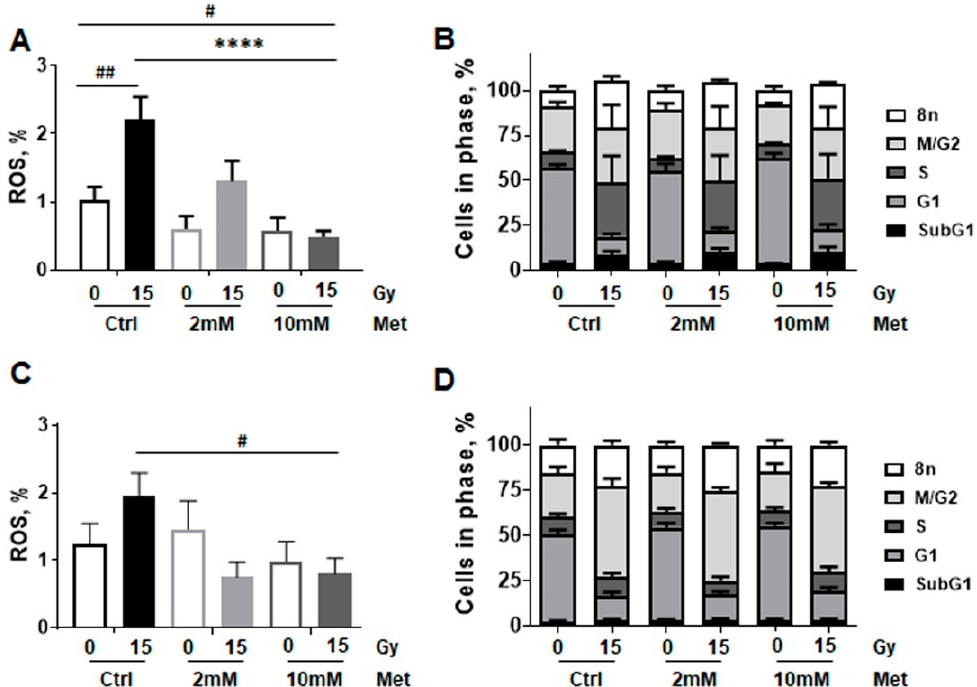
Figure 6. RT-induced cellular stress is reduced upon combined metformin treatment in epithelial cells established from normal lung epithelium. BEAS-2B ( A,B ) and HSAEC1-KT ( C , D ) lung epithelial cells were analyzed concerning reactive oxygen species (ROS) production ( A , C ) at 24 h of post RT and metformin (Met) treatment using dihydroethidium staining in combination with flow cytometry analyses. Data are shown as mean values ± SEM of 5–7 independent experiments. p -value indicates: **** p ≤ 0.0001 by two-way ANOVA with post hoc Tukey’s multiple comparison test and additionally by unpaired (two-tailed) t -tests depicted as # p ≤ 0.05, ## p ≤ 0.01. Respective cell cycle analysis ( B , D ) at that time point were estimated following Nicoletti staining. Data are summarized as mean values ± SEM of 3–5 independent experiments.